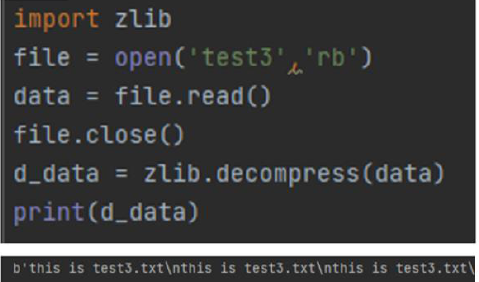
Figure 19. Zlib Python code to decompress files and the result of decompression.